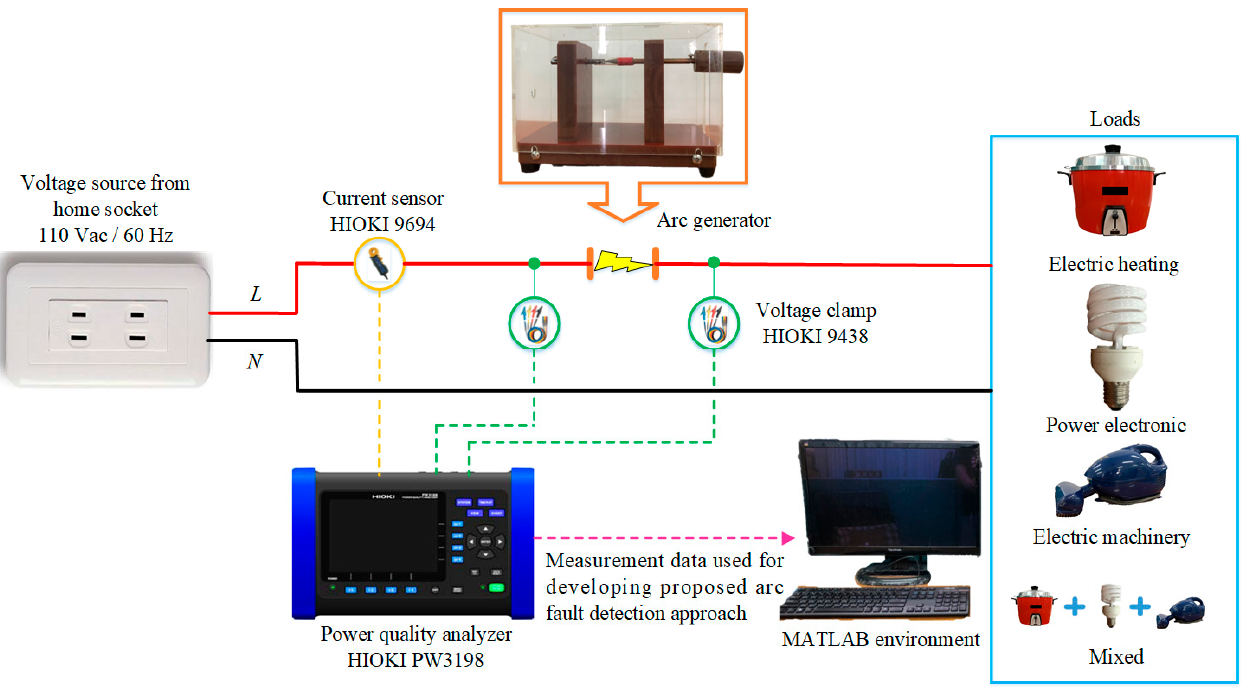
Figure 2. Experimental setup for AC series fault measurements.